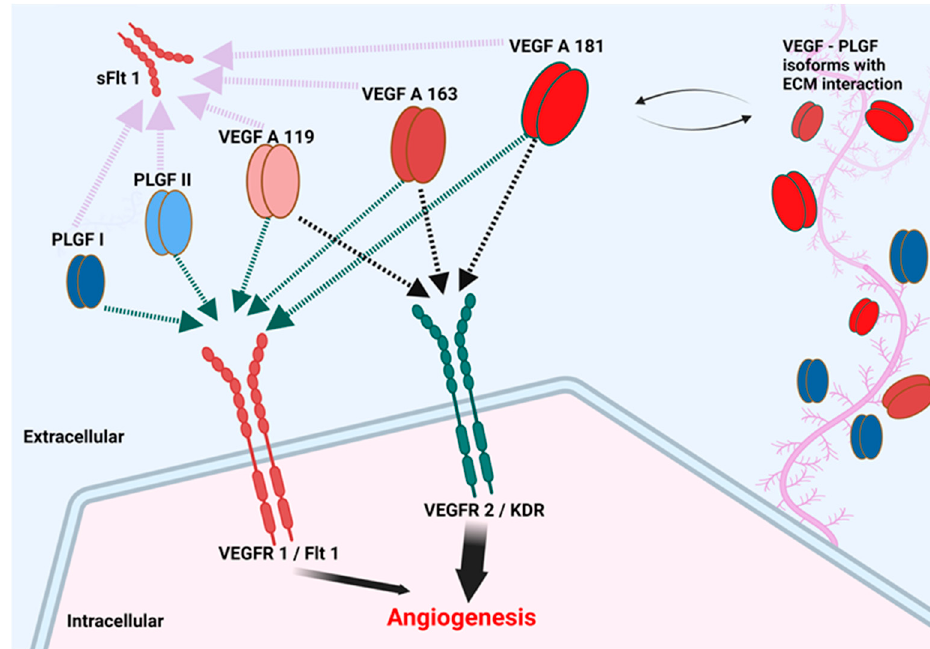
Figure 8. Isoforms of the VEGF-A family and their receptor interaction. Proangiogenic VEGF-A isoforms can bind both Flt-1/VEGFR1 and KDR/VEGFR2, but exert their principal angiogenic effects via KDR. In contrast, PLGF binds Flt-1 selectively and is able to compete with VEGF-A for Flt-1 binding, liberating VEGF to signal through KDR. PLGF II and VEGF-A 119 lack extensive heparin- binding domains and therefore are relatively soluble in the extracellular space, while PLGF I, VEGF- A 163 and VEGF-A 181 interact with the extracellular matrix forming a reservoir in the extracellular matrix (ECM). sFlt-1, a truncated, secreted splice variant of Flt-1, binds ECM and thus can act paradoxically as a competitor for KDR signaling with antiangiogenic effects or as an accessible reservoir for VEGF-A. The ability of either PLGF or sFlt-1 to indirectly affect VEGF-A-stimulated angiogenesis by these mechanisms will depend on their distribution, which in turn are functions of their affinity for extracellular matrix as dictated by splice product dominance.